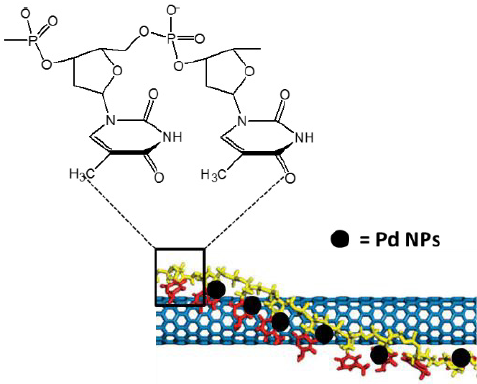
Fig. 1 . FE-SEM images of (a) MWCNTs and (b) Pd/DNA@MWCNTs